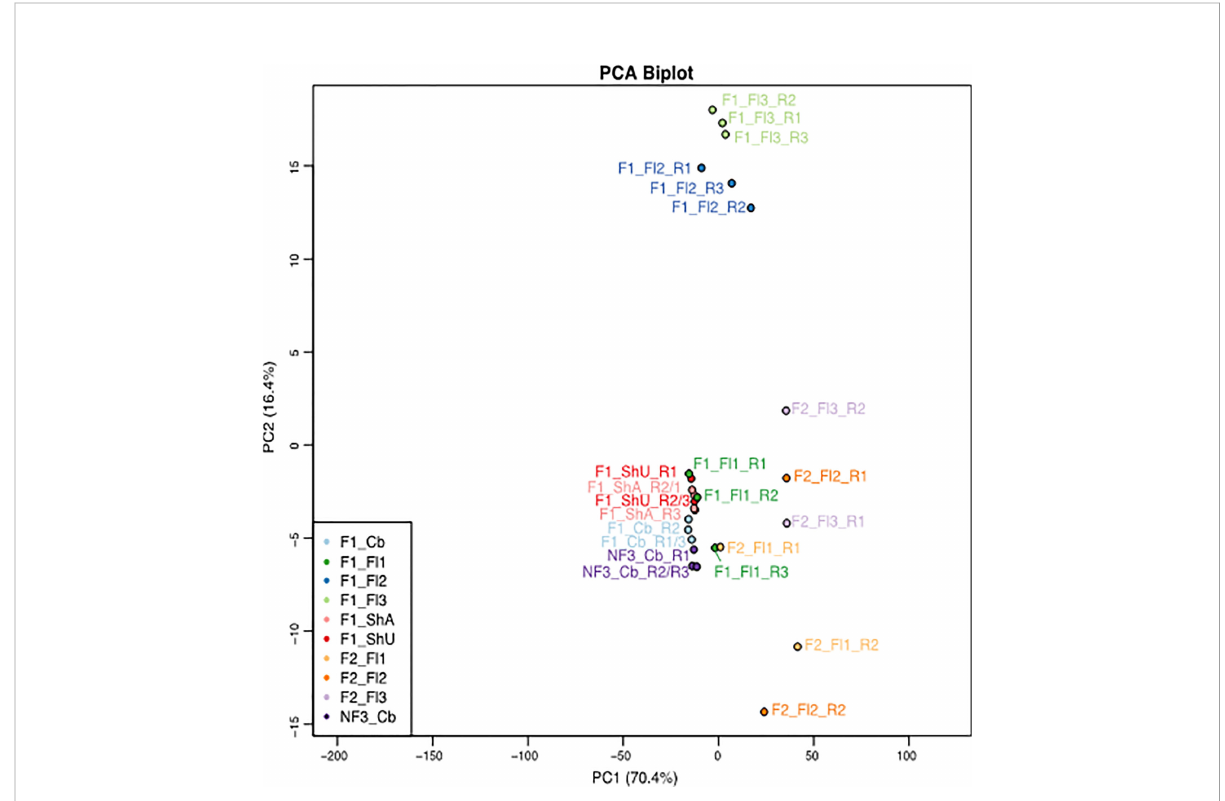
FIGURE 3 PCA plot of the 27 samples of B. oldhamii ‘ Xia Zao ’ generated for this transcriptome study. The samples include one culm buds tissue of three biological replicates from non fl owering clump 3 — labeled as “ NF3_Cb ” , six tissues each with three biological replicates from fl owering clump 1 – labeled as “ F1 ” , as well as three tissues each with two biological replicates from fl owering clump 2 – labeled as “ F2 ” . “ Cb ” – culm buds, “ ShU ” – underground shoots, “ ShA ” – aboveground shoots, “ Fl1 ” – fl ower stage 1 with each spikelet length less than 1 cm, “ Fl2 ” – fl ower stage 2 with each spikelet length between 1cm and 1.5 cm, “ Fl3 ” – fl ower stage 3 with each spikelet length greater than 1.5 cm.